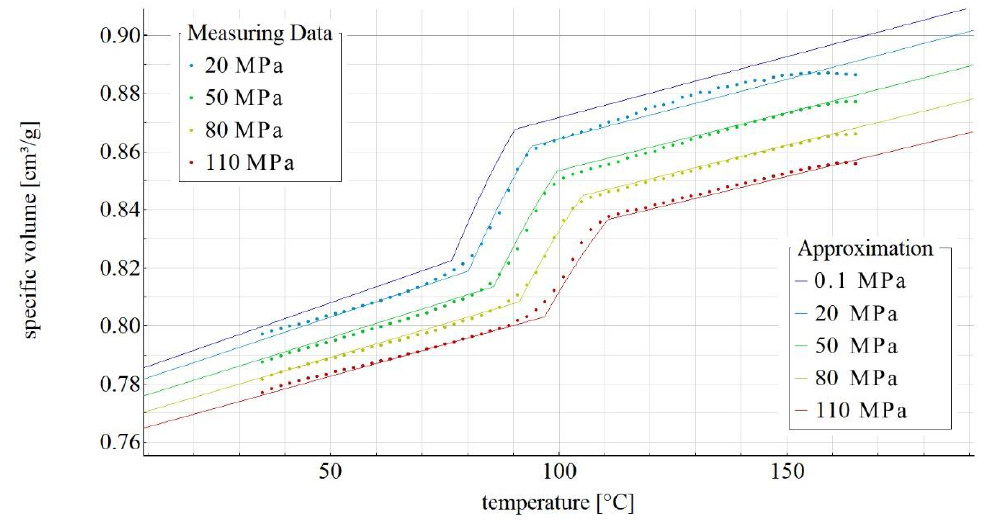
Figure 3. p-v-T diagram for polybutylene succinate containing 10% by weight of ground wheat bran.